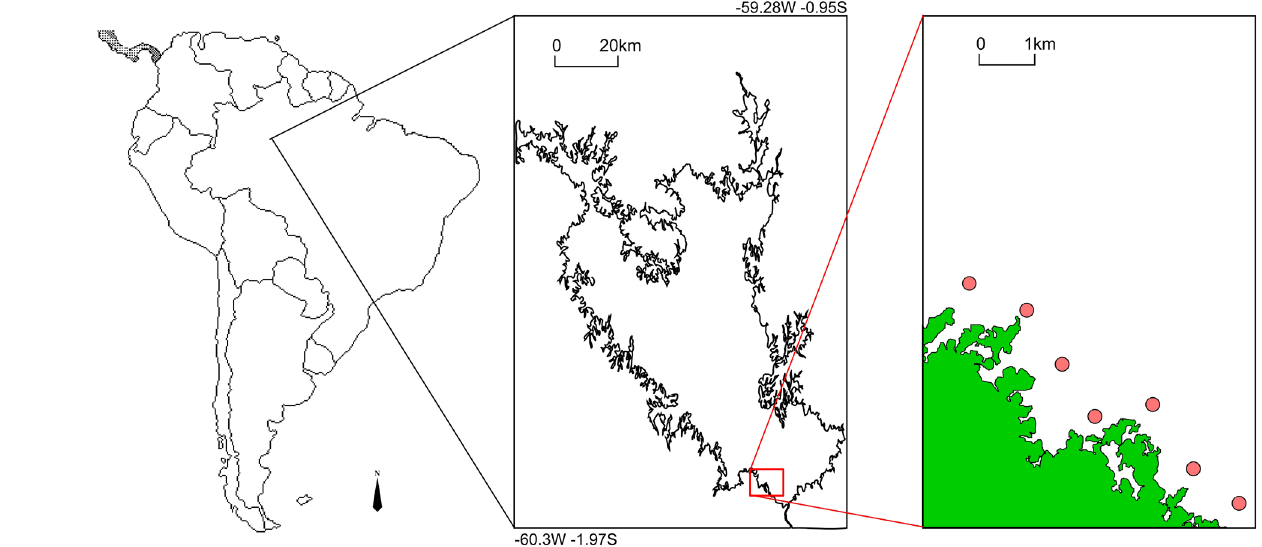
Localization of the Balbina Hydroelectric plant and the sampling points in the ghost forest. The green area represents the terra firme forests and the red dots represent the sampling areas. The terra firme sampling plots are not represented but are in the same areas as the five ghost forest